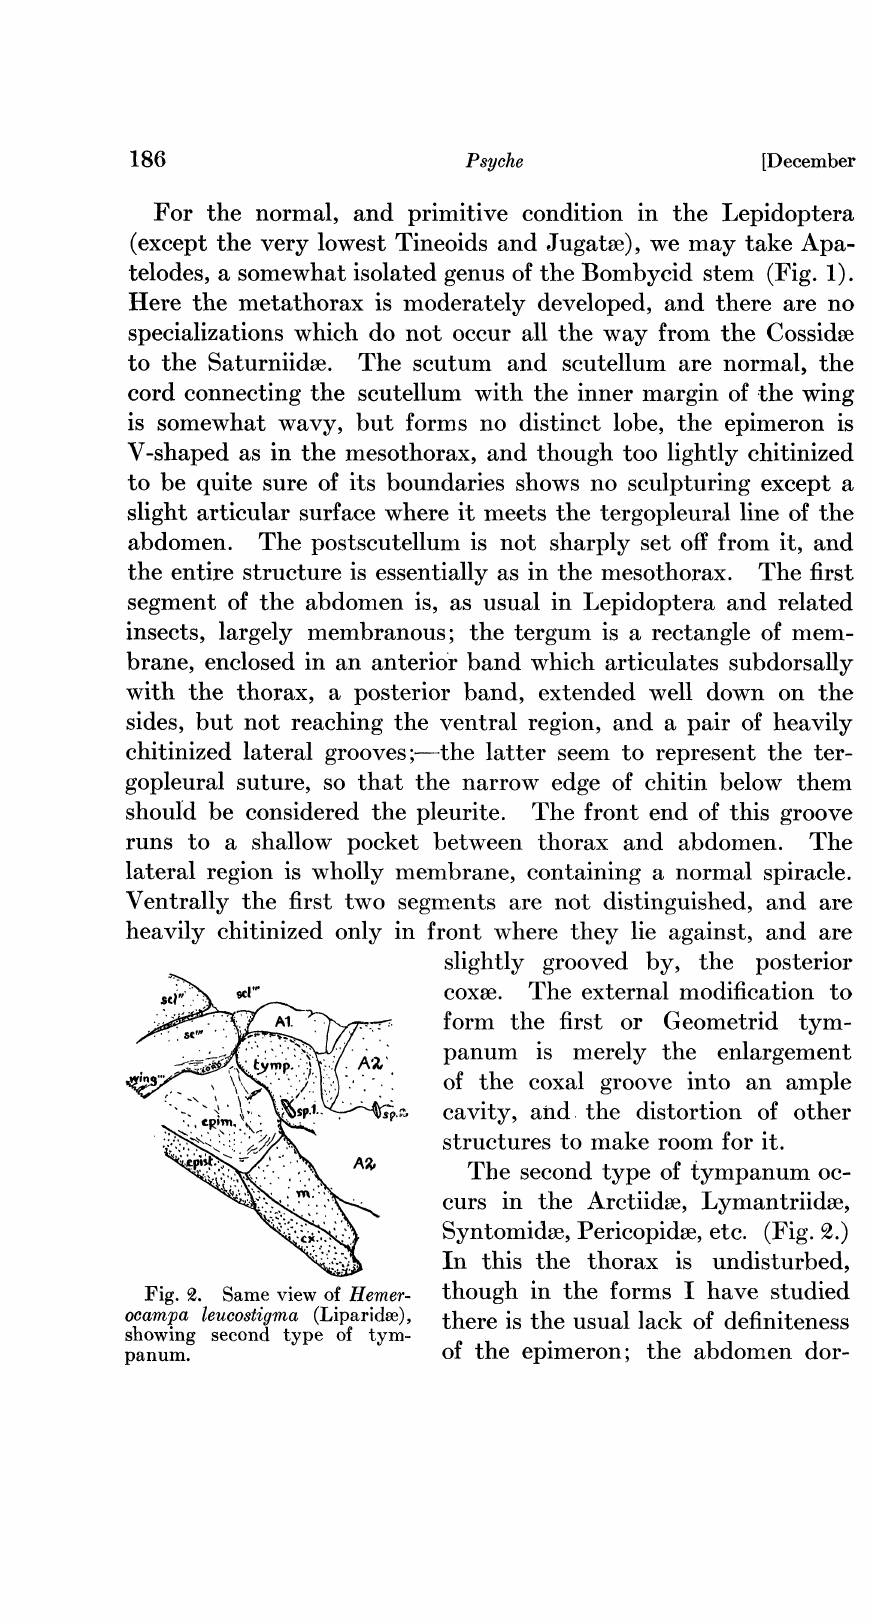
Fig. 2. Same view of Hemer- ocampa leucostigma (Liparida), showing second type of tym- panum.